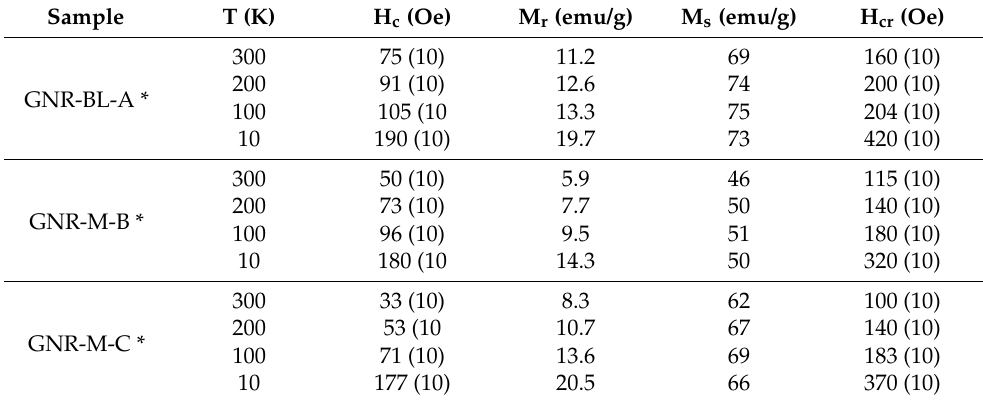
Table 4. Magnetic parameters obtained from M ( H ) at different